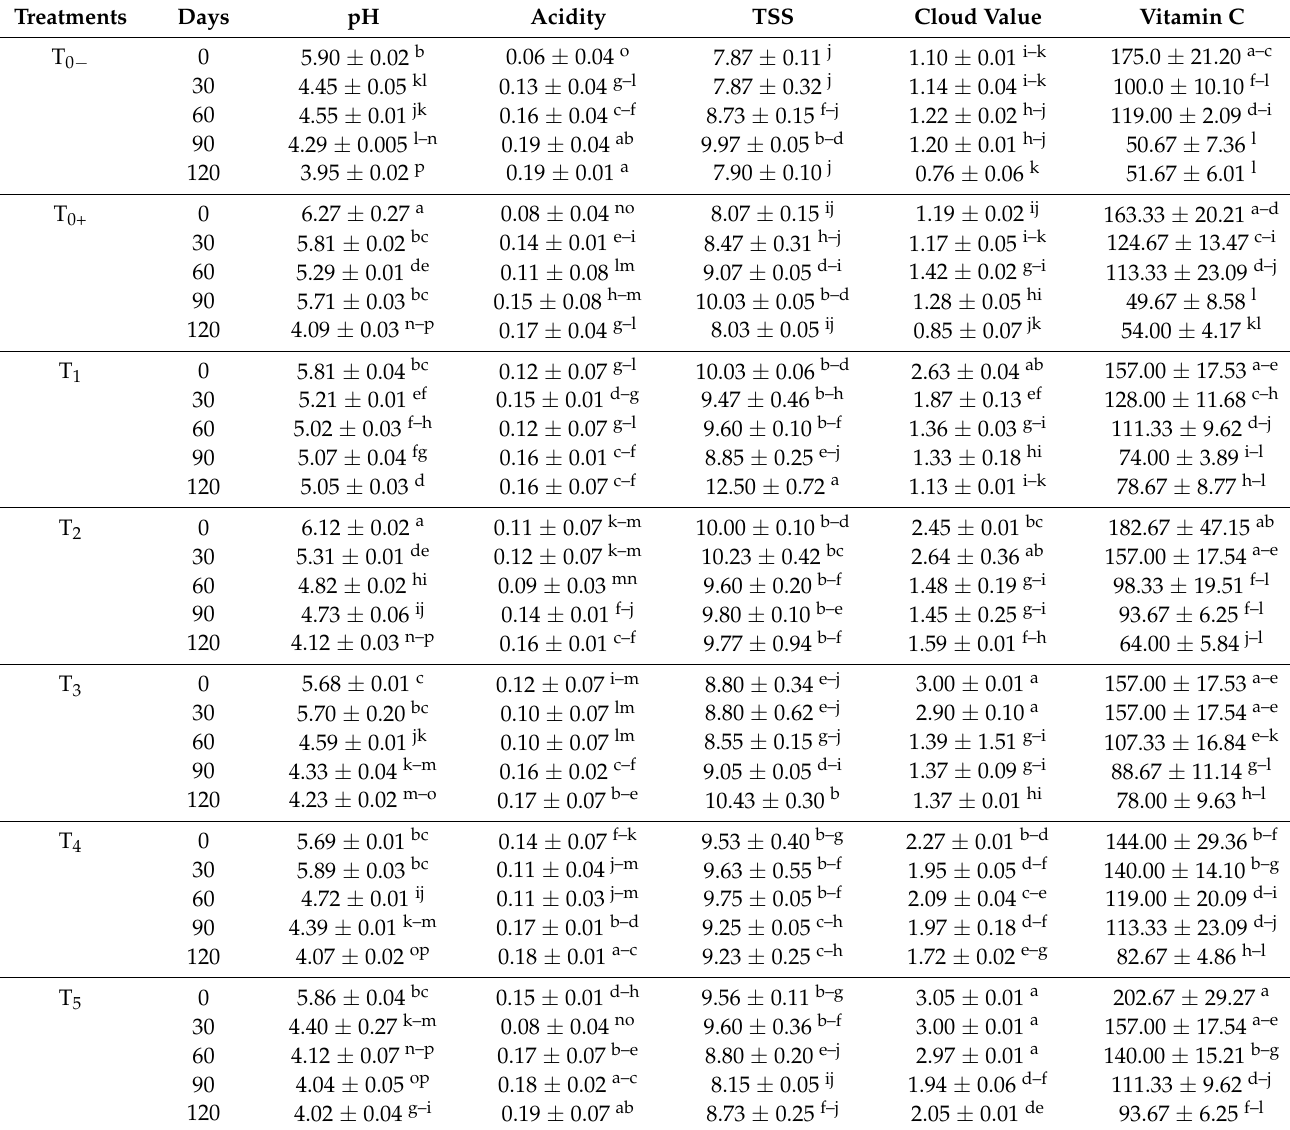
Table 2. pH, acidity, total soluble solids (TSS measured in ◦ B), cloud value, and vitamin C (mg/100 mL of juice) of the watermelon juice during